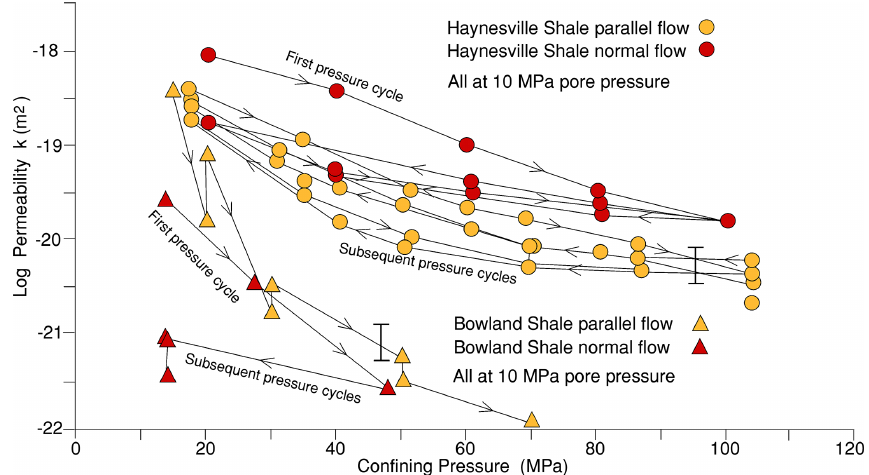
Figure 4. Comparison of data at 10MPa pore pressure for flow parallel and normal to layering in the two shales. Parallel flow data are shown without the first pressure cycle, during which some pores become permanently closed. Normal-to-layering flow data are shown including the first pressure cycle. For Bowland shale, flow normal to layering is slower, but for Haynesville shale there is little effect, except that pressure sensitivity is less for flow normal to layering.